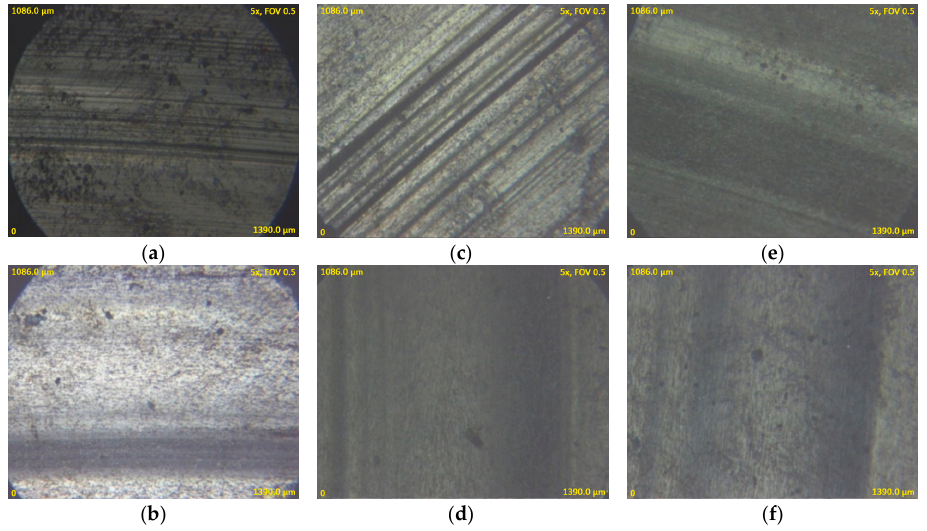
Figure 13. Worn surfaces of ceramic balls at friction speed (m/s): ( a ) 0.2, ( b ) 0.4, ( c ) 0.6, ( d ) 0.8, ( e ) 1.0, ( f ) 1.2.